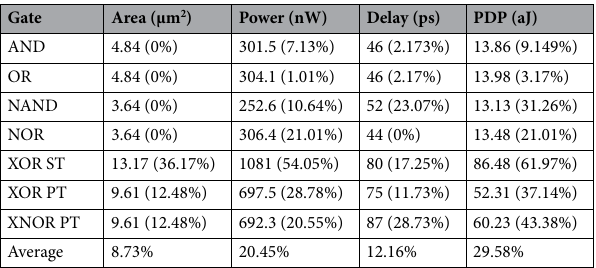
Table 26. Analysis of design overheads for Key based logic encryption along with % of improvements when compared with proposed logic encryption.